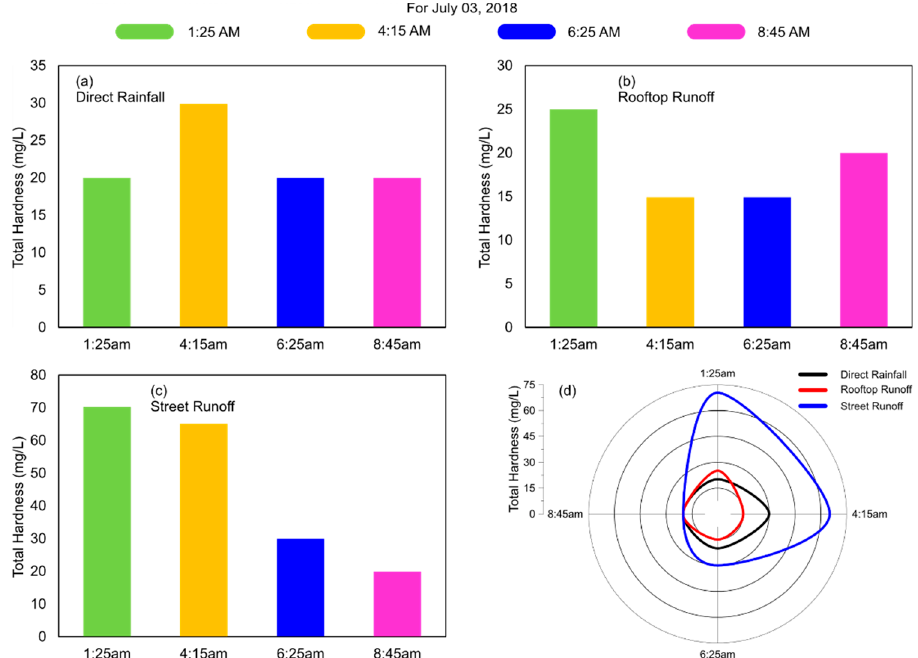
Figure 10. Intraday profile of total hardness (mg/L) (on 3 July 2018) at Site S3—Field Research Station Babakwal, Tehsil Ferozewala, District Sheikhupura, where ( a ) represents direct rainfall, ( b ) represents rooftop runoff, ( c ) represents street runoff, and ( d ) illustrates comparative analysis of the three selected categories on polar chart for different rainfall events.